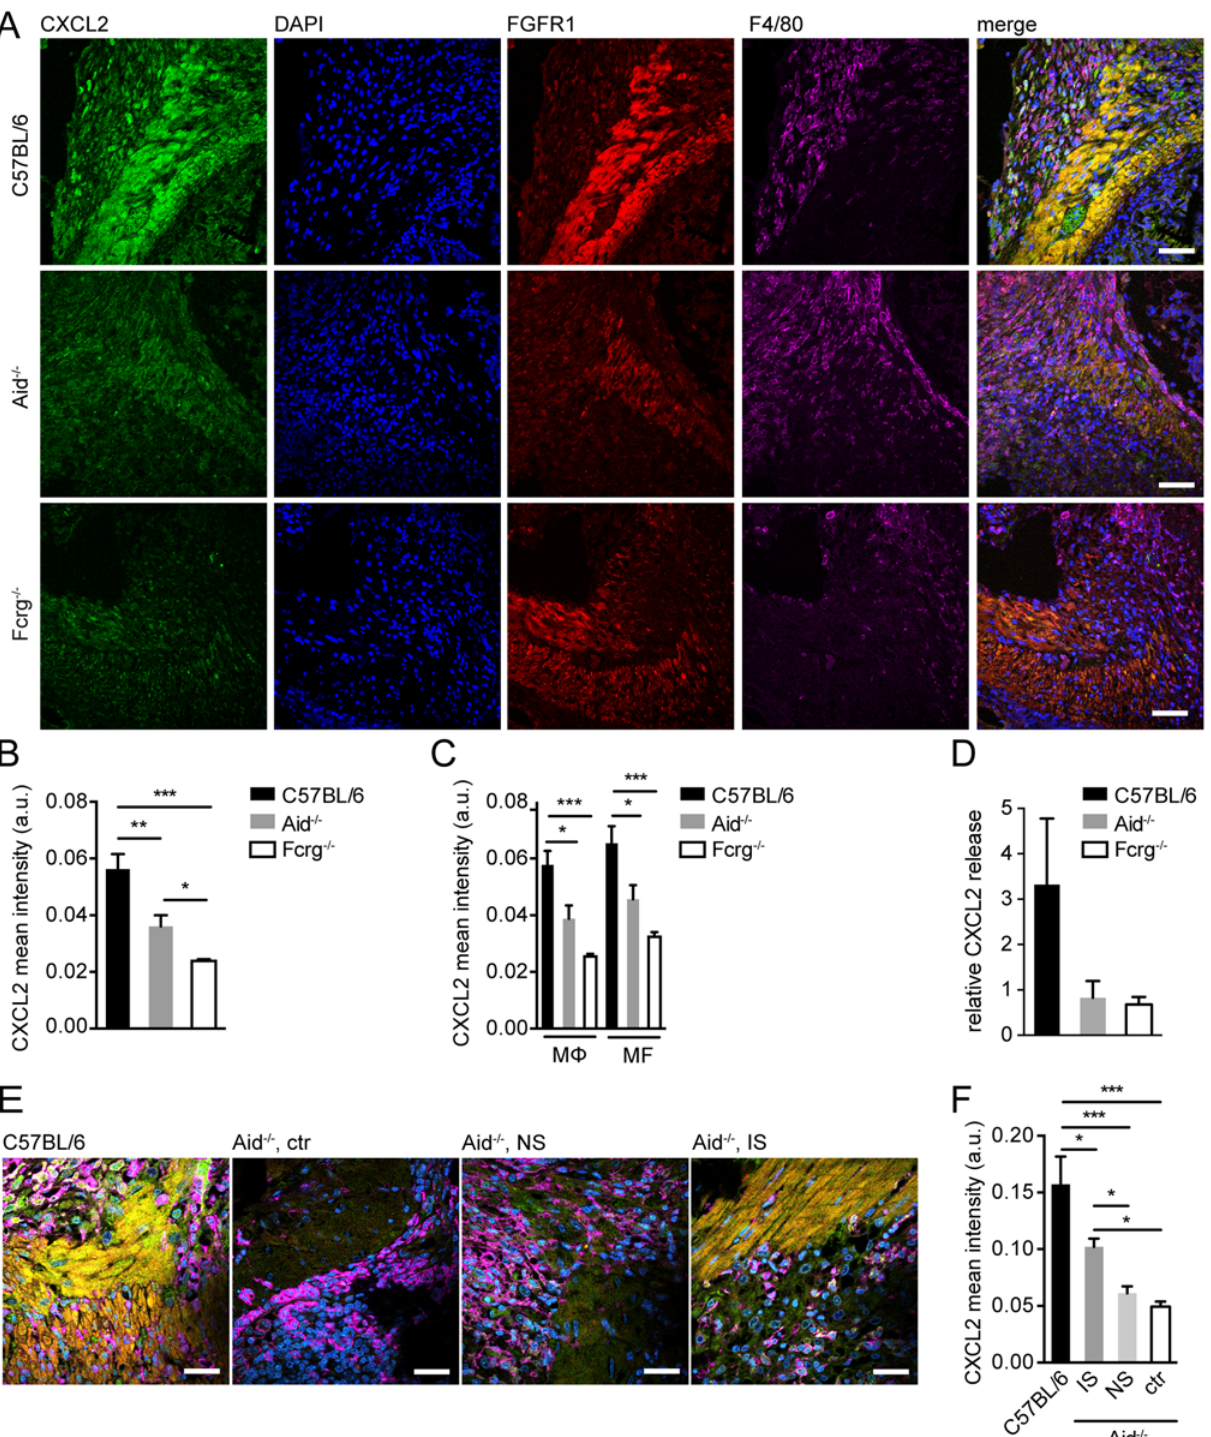
Fig 2. Antibody and Fcrg-dependent mechanisms trigger CXCL2 expression during helminth infection in vivo. Small intestinal tissues from Hpb challenge-infected mice were either used for immunofluorescence (IF) staining for CXCL2/3 (green), FGFR1 (MF, red), F4/80 (M Φ , magenta) and counterstaining by DAPI (blue) or for overnight tissue culture for ELISA quantification of CXCL2 in culture supernatants, IF quantification was performed using CellProfiler; (A) Representative images of IF staining for CXCL2, FGFR1, and F4/80 in intestinal lesions from C57BL/6, Aid -/- or Fcrg -/- mice; (B) Quantification of mean ( “ per cell ” ) CXCL2 fluorescence intensity in IF-stained intestinal lesions from C57BL/6, Aid -/- or Fcrg -/- mice; (C) Quantification of mean CXCL2